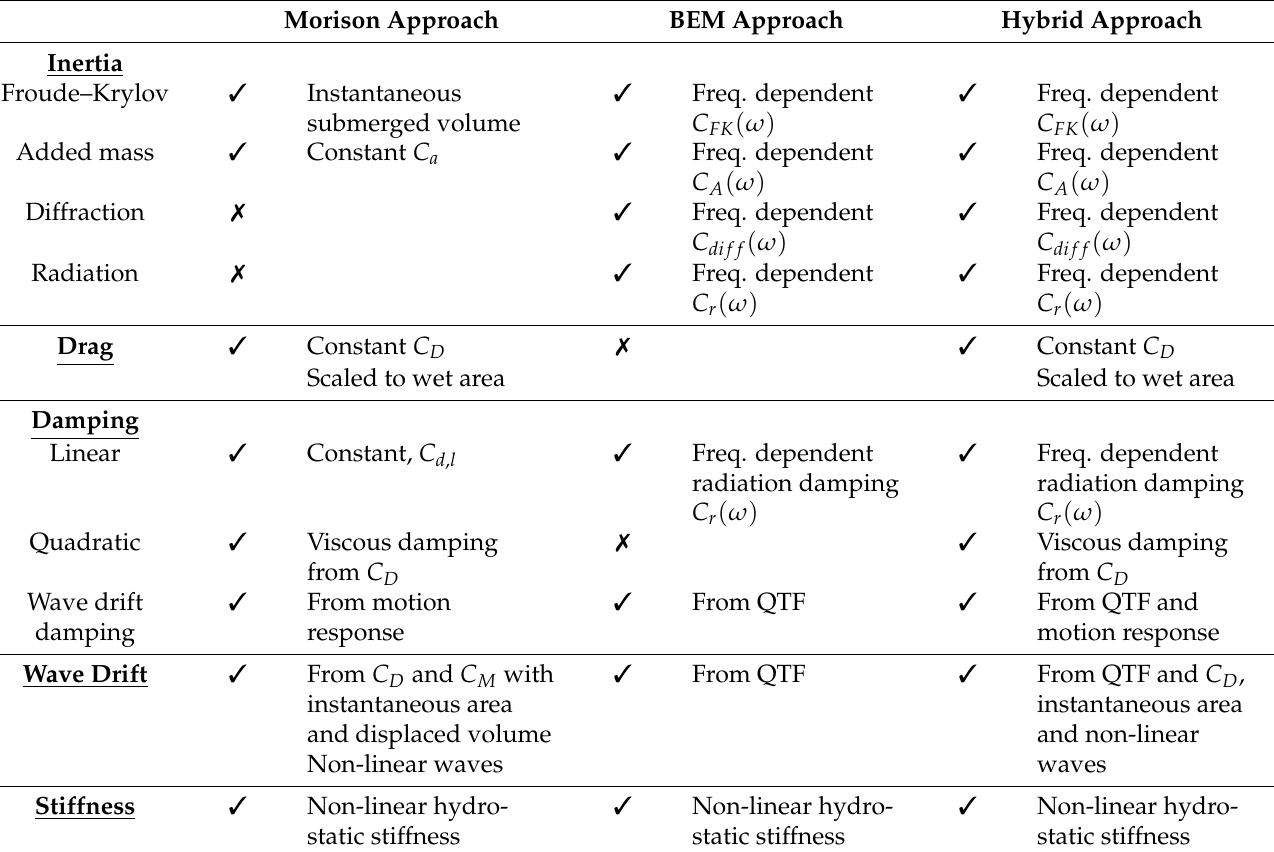
Table 4. Comparison of the included effects in each modelling